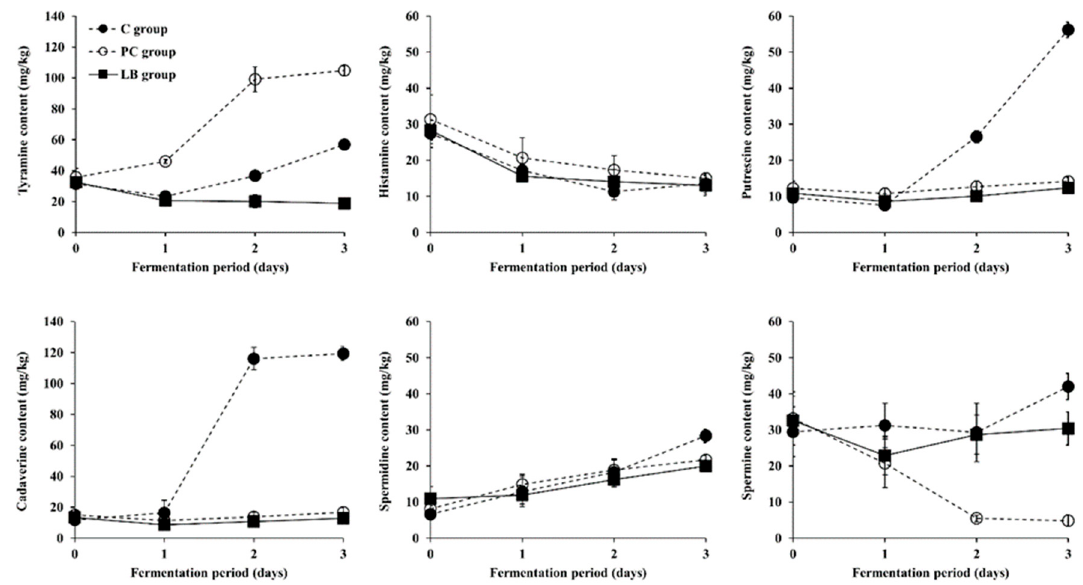
Figure 3. Changes in BA content in Baechu kimchi inoculated with a LAB strain leading to significant tyramine reduction during fermentation. ● : C group without an inoculum (control), ○ : PC group inoculated with tyramine-producing L. brevis isolated from kimchi product (positive control), ■ : LB group inoculated with BA-degrading L. brevis PK08.